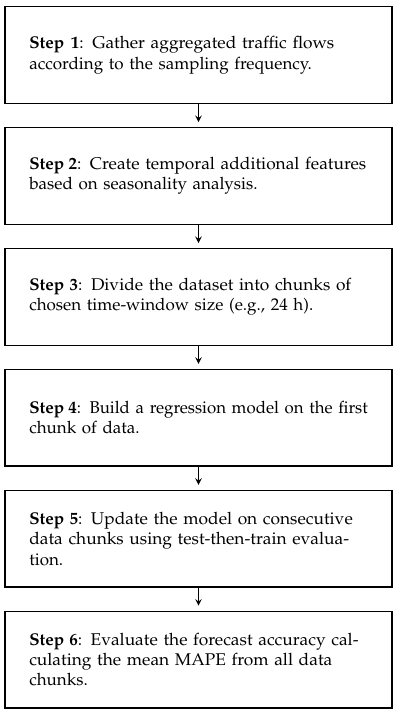
Figure 9. Machine learning-based traffic prediction–the